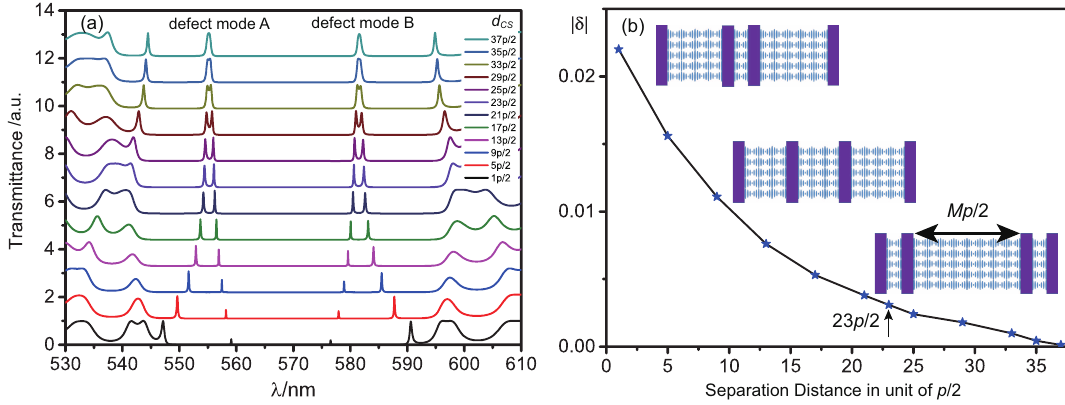
Figure 3. ( a ) evolution of the transmission spectra of a MDL-CLC structure with two defect layers with increasing distance between the defect layers; ( b ) relation between coupling factor | δ | and separation distance between defect layers. The whole thickness of the CLCs inside two boundary layers is 69 p/2 .